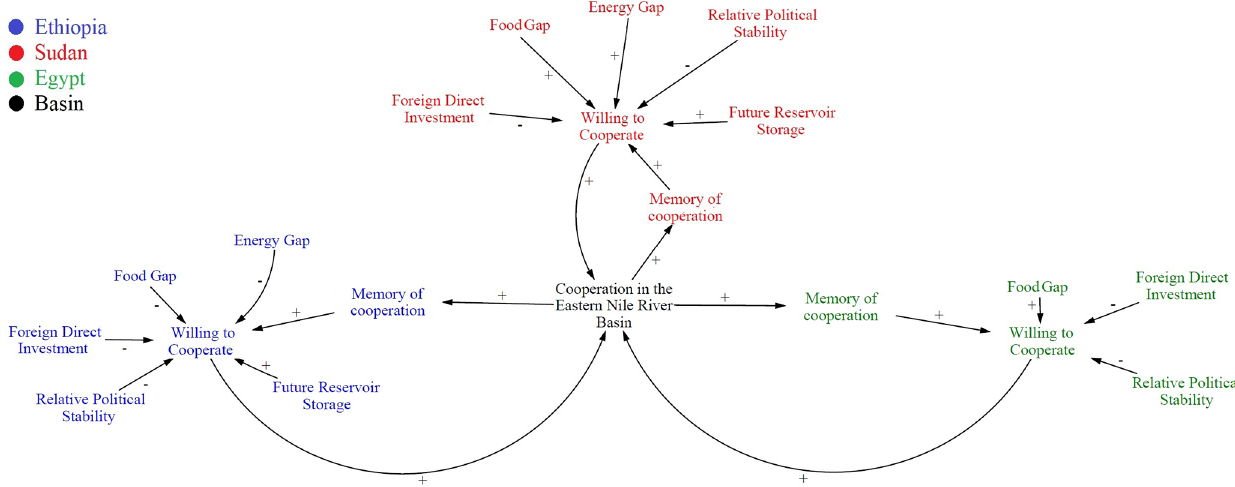
Figure 3. Conceptualization of the Eastern Nile Basin Socio-hydrological (ENSH) model. Signs indicate positive ( + ) and negative ( − ) effects. The colors of blue, red, green, and black indicate the variables of Ethiopia, Sudan, Egypt, and the basin,